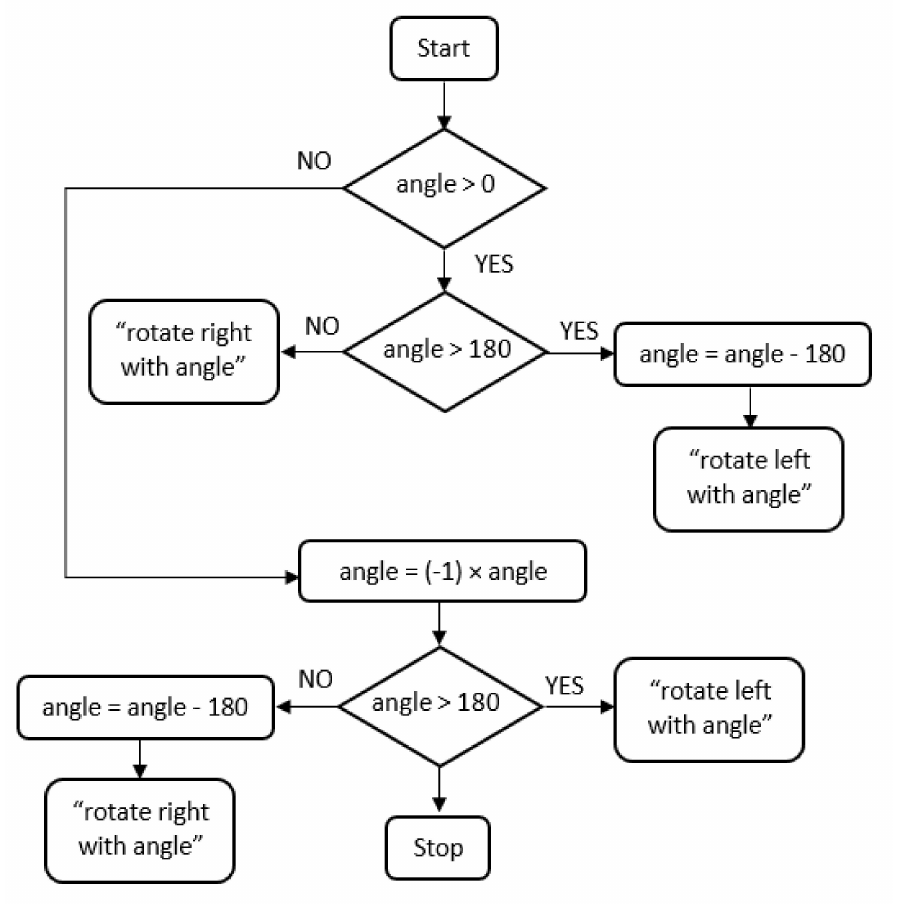
Figure 7. Diagram to set